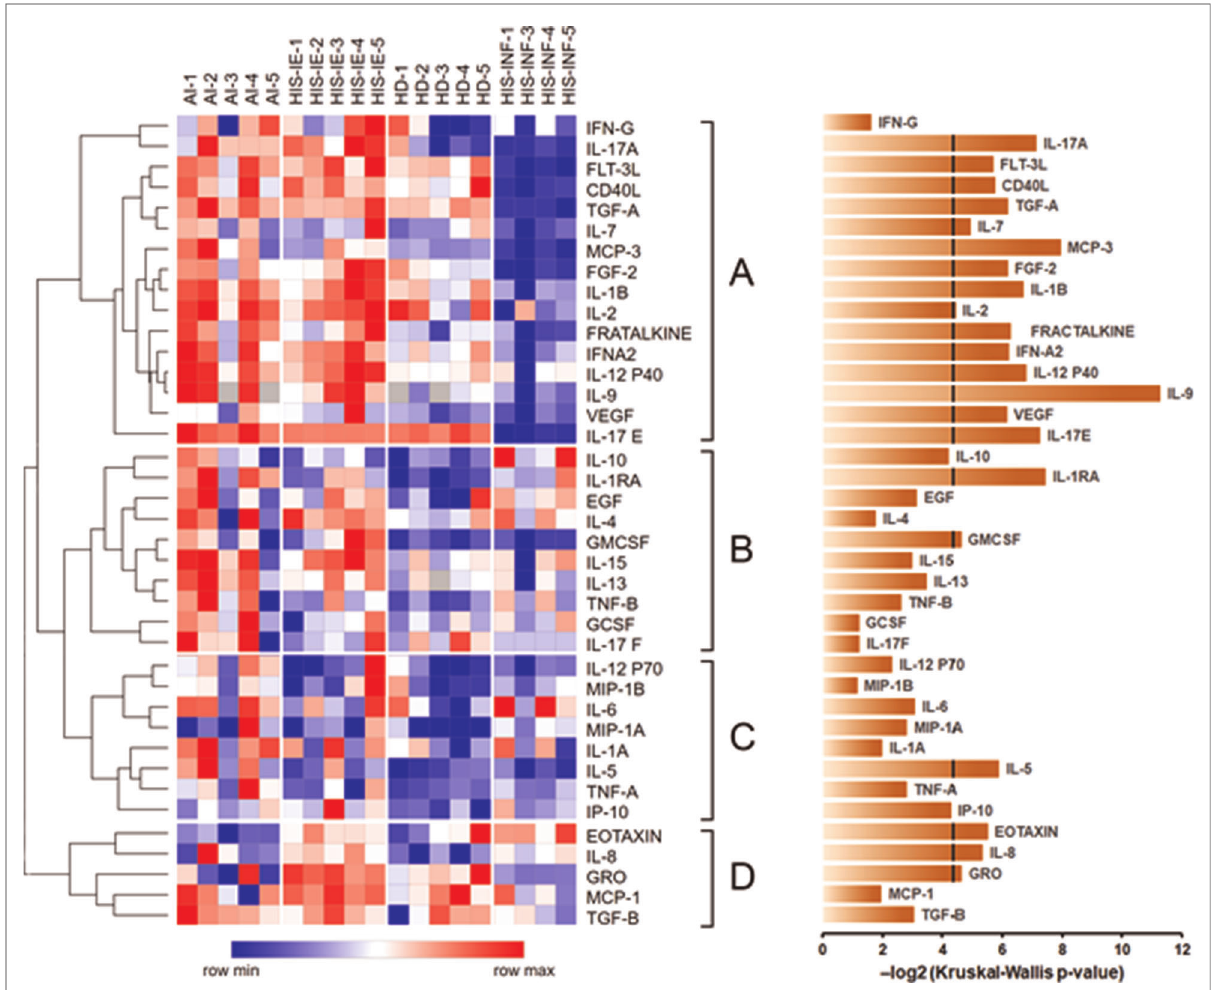
FIGURE 2 Global cytokine differential expression in plasma among HD, AI/CI, HIS-IE, HD, and HIS-IFN. Heatmap of log 2 -transformed cytokine concentrations measured in the tested samples. Cytokines were clustered using Spearman rank correlation with complete linkage. The major clusters are sequentially labeled A – D to the right of the heatmap. The heatmap was constructed using Morpheus. The bar graph on the right shows negative log 2 -transformed p -values for each cytokine based on the Kruskal – Wallis analysis across the four groups. The line crossing some of the bars at the 4.322 value corresponds to the p -value of 0.05. HD, healthy donors, AI, autoimmune, HIS-INF, HIS in fl amed, HIS-IE, HIS immune